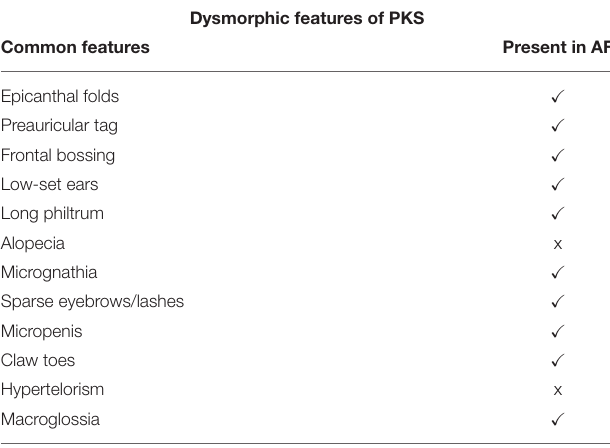
TABLE 1 | Dysmorphic features of Pallister–Killian syndrome